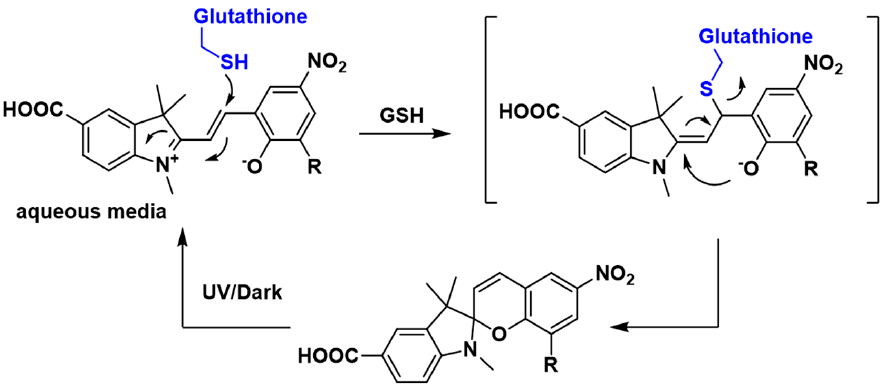
Figure 4. Possible mechanism for reversible binding of γ -Glutamyl-cysteinyl-glycine (GSH) to sensor 1 .